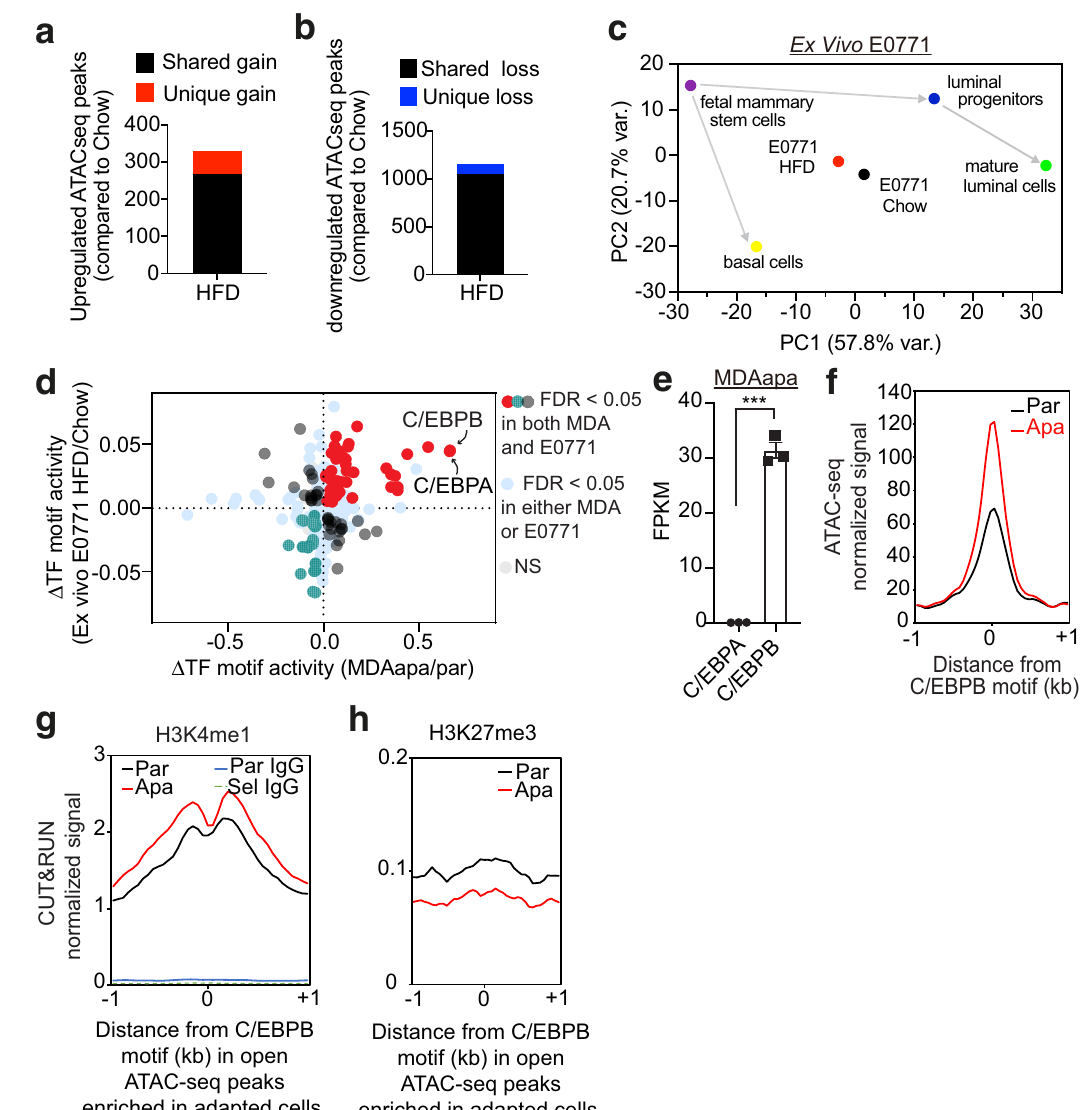
Fig. 3 Adaptation to obese environments induces open chromatin linked with C/EBPB occupancy. a , b Total number of signi fi cantly upregulated ( a ) and downregulated ( b ) ATACseq peaks in E0771 HFD ( n = 3) relative to chow ( n = 4) by DiffBind with a false discovery rate (FDR) < 0.05. Unique gain ( a ) or loss ( b ) peaks refer to the peaks identi fi ed only in the HFD or chow condition, respectively, whereas shared peaks are peaks called in both conditions. c Principal component analysis showing principal components (PC) 1 and 2 of E0771 ex vivo cells and different cell lineages along the mammary gland developmental trajectory (GEO: GSE116386) using the average transcription factor motif activity estimated by chromVar. d Overlap of differential transcription factor binding motif activity between MDA-MD-231 (apa/par) and E0771 (HFD/Chow) as determined by diffTF. e Within-sample normalized gene expression of transcription factor homologs C/EBPA and C/EBPB in PA-adapted MDA-MB-231 cells using RNA-seq. FPKM = fragments per kilobase of transcript per million mapped reads. Data are represented as mean ± SEM of 3 replicates from each group. Statistical signi fi cance determined with unpaired, two-tailed Student ’ s t -test ( P < 0.0001). f Metagene representation of the mean ATACseq signal across more accessible C/EBPB motif regions in parental ( n = 3) or adapted ( n = 3) MDA-MB-231 cells. The mean signal of three adapted or parental MDA-MB-231 biological replicates was determined by averaging signals of 1 kb around the center of C/EBPB DNA-binding motifs. g , h Metagene representation of the mean H3K4me1 (par n = 2; apa n = 2) and IgG signals ( g ) and the mean H3K27me3 signals (par n = 3; apa n = 3) ( h ) across more accessible C/EBPB motif regions as in ( f ) in MDA-MB-231 cells. The mean signals of biological replicates were determined by averaging signals of 1 kb around the center of C/EBPB DNA-binding motifs. Source data are provided as a Source data fi